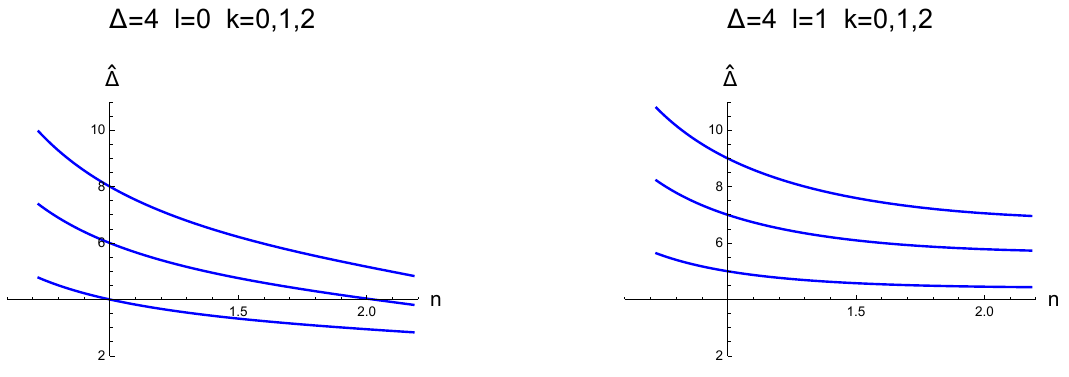
Figure 10 . Plots of defect operator scaling dimension in a holographic model Renyi index n . In the bulk we work with a massless scalar ( (cid:22) = 0 and (cid:1) =